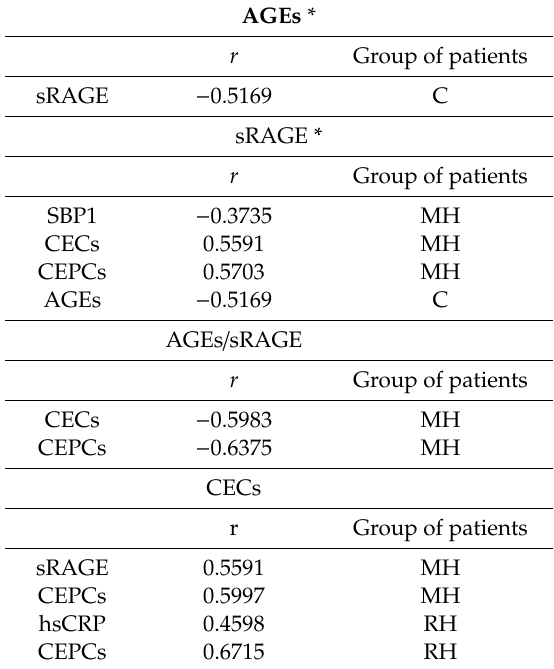
Table 2. The correlations coe ffi cients for AGEs, sRAGE, AGEs / sRAGE, CEPCs, CECs and CEPCs / CECs in the studied groups of